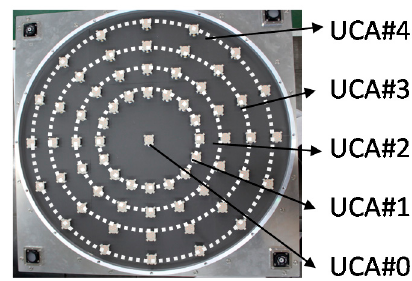
Figure 8. Implemented multiple uniform circular arrays (Four UCAs and a center antenna).